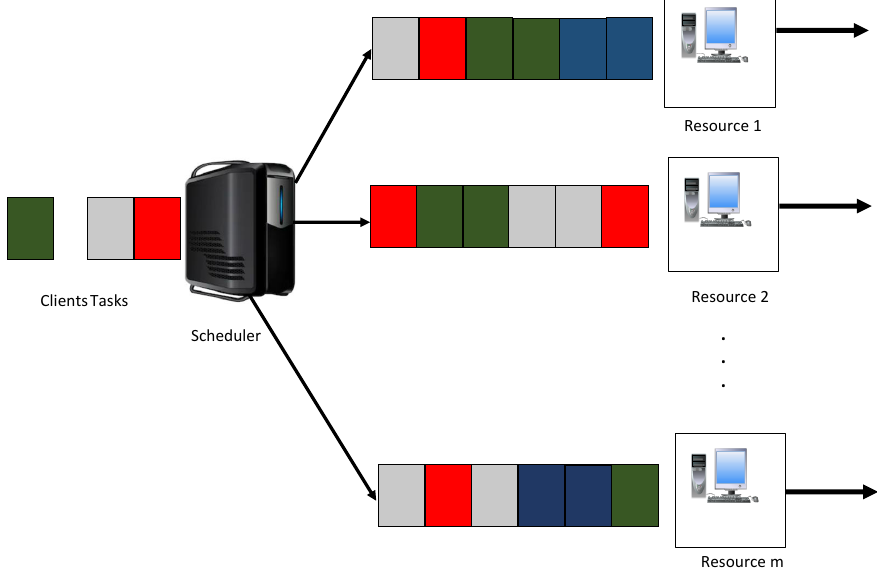
Figure 3. Model of IoT Grid Job